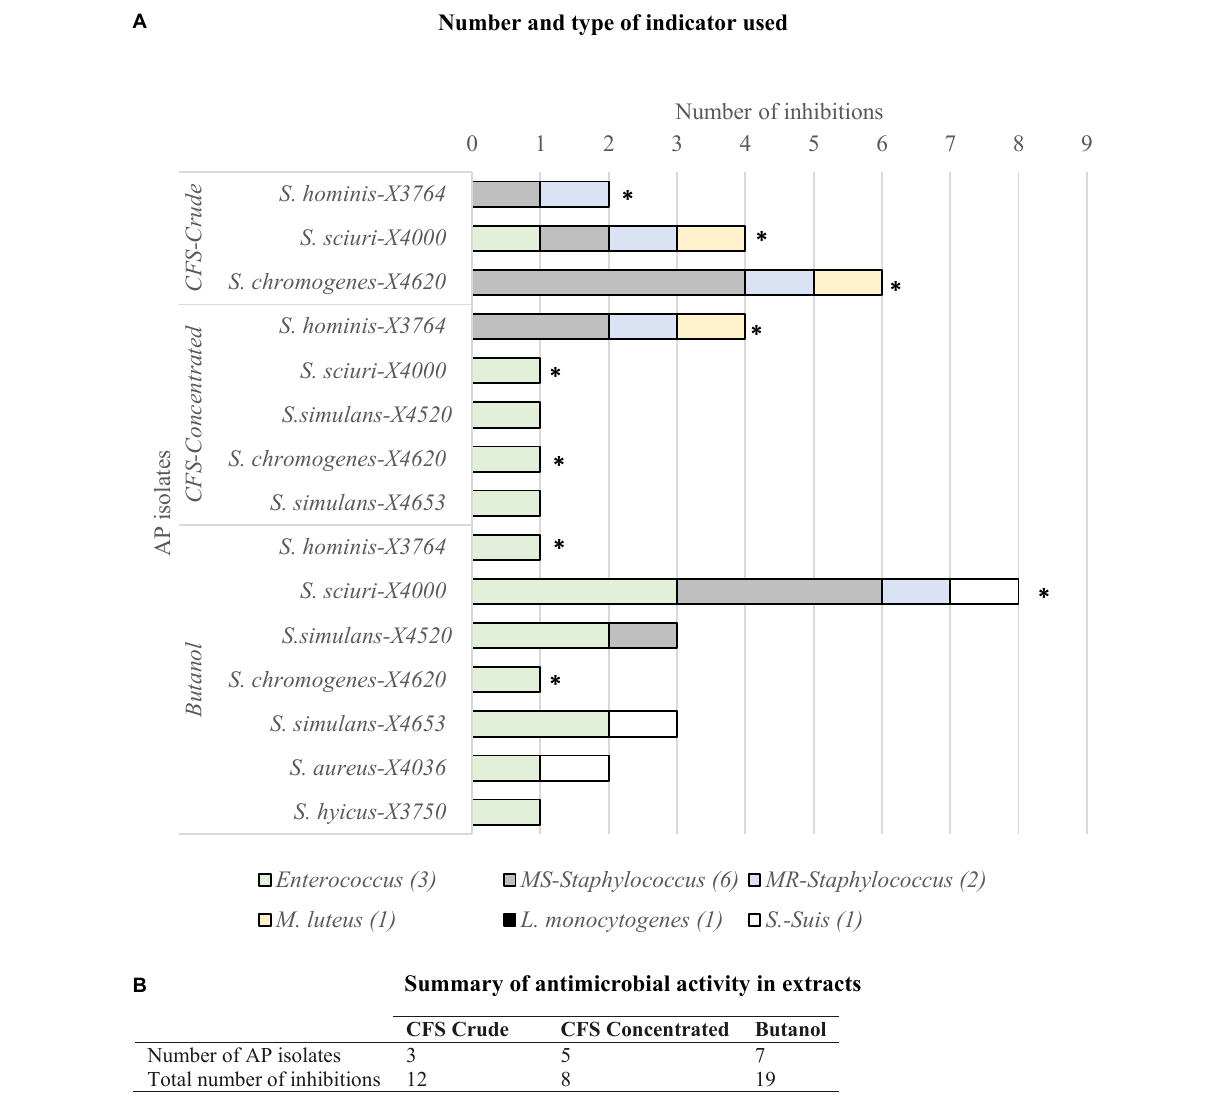
FIGURE2 (A) Number of indicator bacteria ( n = 14) inhibited by different preparations of the nine antimicrobial producer (AP) isolates of stork nasotracheal microbiota: crude CFS (boiled or filtrated), concentrated CFS, and after butanol extraction. (B) Number of AP isolates with antimicrobial activity in the three extract conditions tested and their respective total number of inhibitions. ∗ Antimicrobial producing isolates with antimicrobial activity in the three conditions tested ( S. hominis X3764, S. sciuri X4000, and S. chromogenes